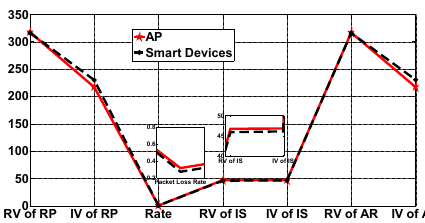
Figure 9. The parameters to characterize the channel interference for different wireless transmitters.